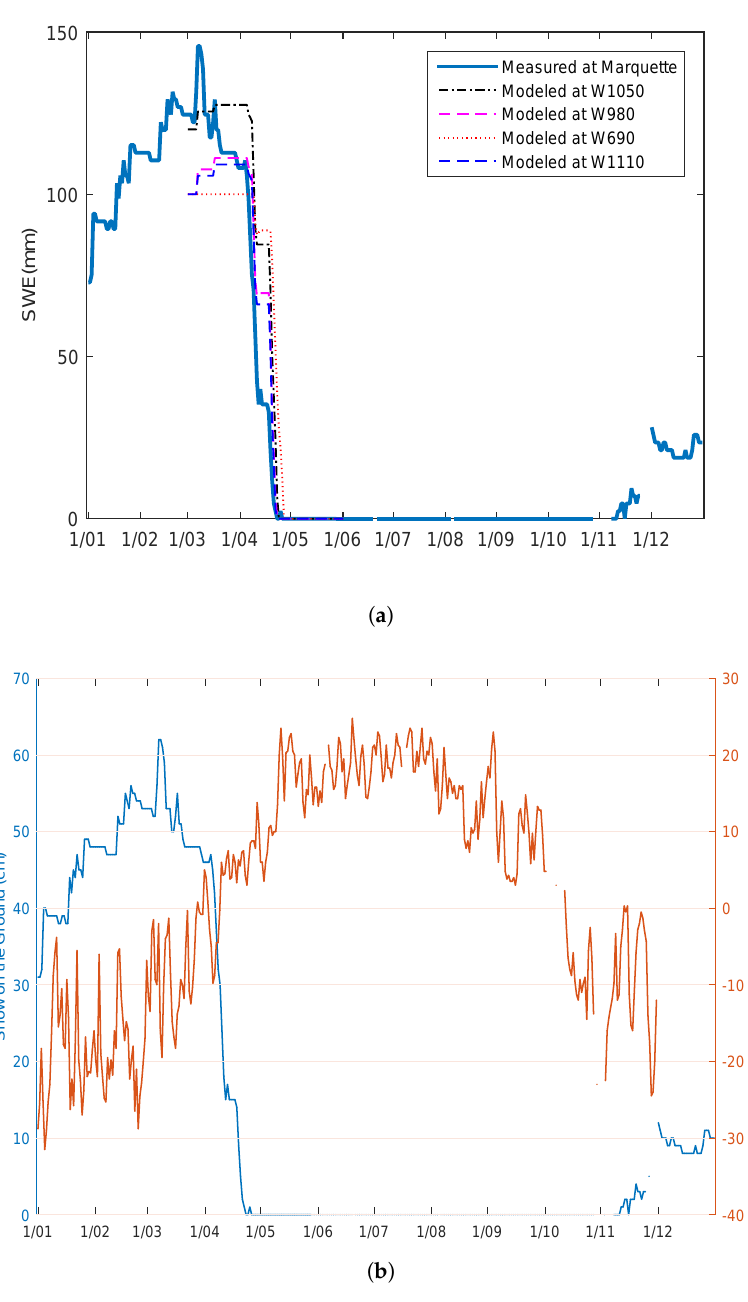
Figure 9. Validation of snow water equivalent (SWE) and timing of spring melt with temperature. ( a ) Comparison of measured and simulated snow water equivalent (SWE); ( b ) observed snow accumulation and melt pattern with